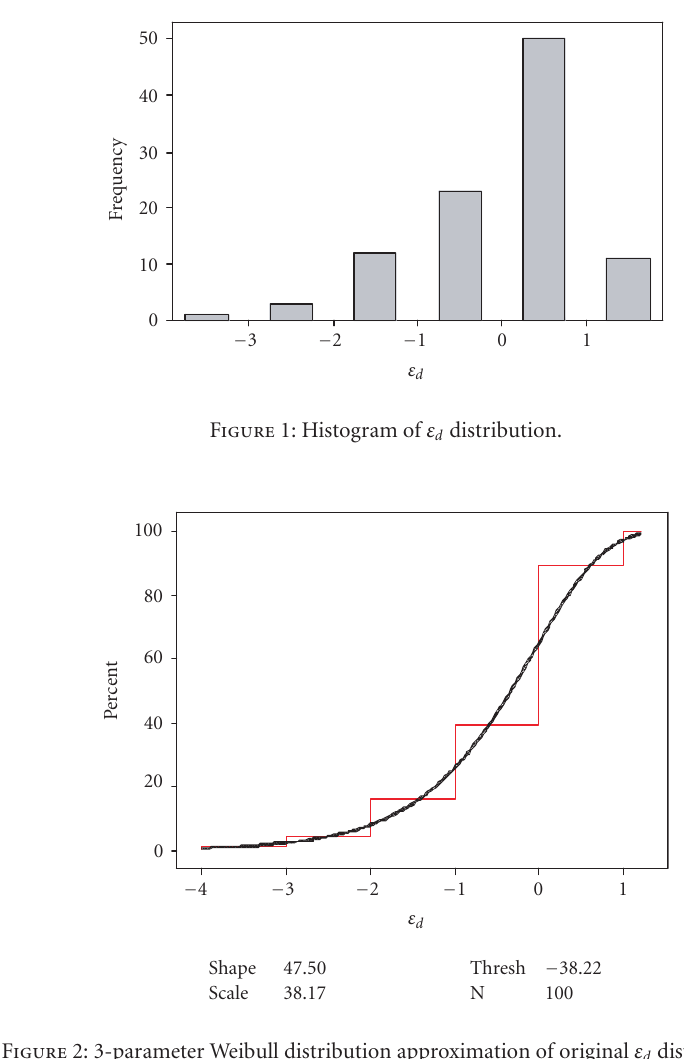
Figure 2: 3-parameter Weibull distribution approximation of original ε d